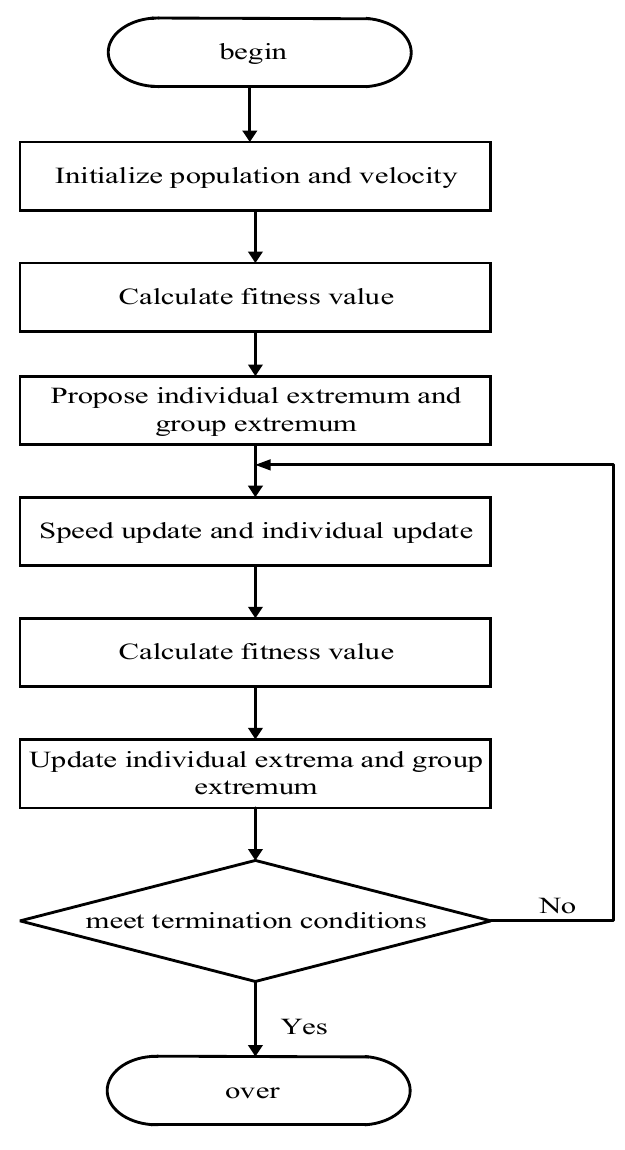
Figure 11. Flowchart of standard particle swarm algorithm. Because the genetic algorithm does not have memory, the offspring will lose the information of the parent during the iteration process, while the particle swarm algorithm is prone to premature convergence and falls into the local optimal solution [67,68]. Therefore, a genetic particle swarm hybrid algorithm (GA-PSO) optimization algorithm based on the particle swarm algorithm and introducing the crossover operation and mutation operation of the genetic algorithm is adopted [69]. The memory function of the particle swarm algorithm for the current optimal solution and the global search function of the genetic algorithm are fully utilized to avoid the optimization algorithm falling into the local optimal solution, and at the same time, the convergence speed is improved and the optimization time is shortened [70]. The process is shown in Figure 12 [60].